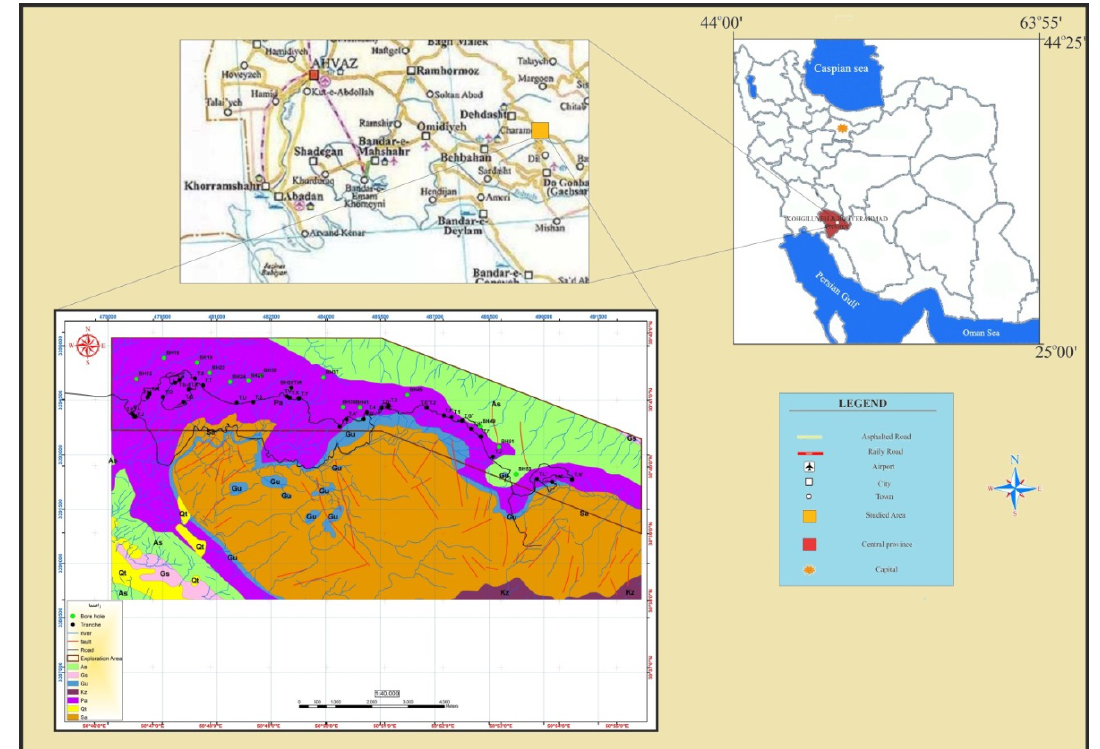
Fig. 1. Geological map of exploration area and the nose parts of Lar Anticline with access to the